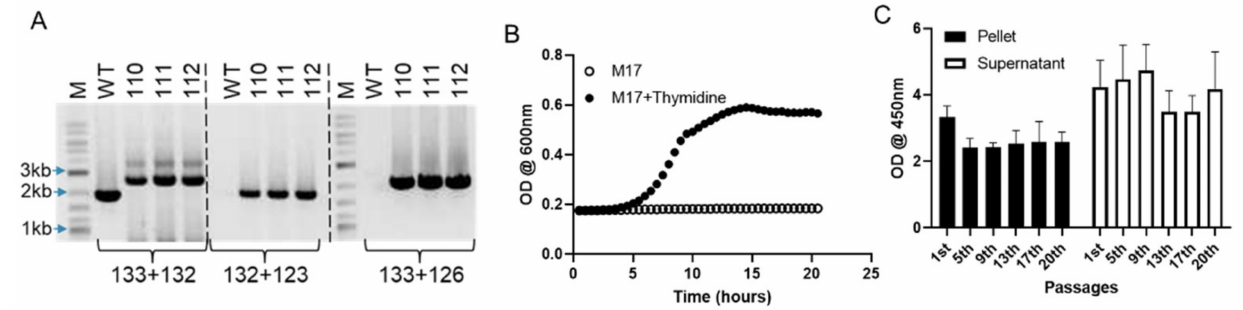
Figure 1. Generation of a SlpA-expression bacterial strain. ( A ) Primers 132 and 133 were used to screen for SlpA+ and Thy- colonies that amplify ~2 Kb amplicon in WT and ~2.6 Kb amplicon in SlpA+ integrated colonies; primers 132 and 123 are specific for integrated SlpA amplifies a gene specific amplicon. Primer sets 132 and 123, as well as 133 and 126 were used to further confirm the integrated SlpA in the colonies. Results represent PCR confirmation of three different clones. ( B ) Representative growth curve of clone R110 in M17 media with and without thymidine supplementation. Bacteria were incubated with the M17 media with and without thymidine supplementation in a 96 well plate, and growth was measured by OD660nm every 30 min for 20 h. ( C ) Stability of the SlpA cassette was demonstrated by culturing bacteria for 20 generations. Expression of SlpA was detected in the cell pellet and supernatants from passages 1st, 5th, 9th, 13th, 17th, and 20th by ELISA; experiment was run in triplicates; mean +